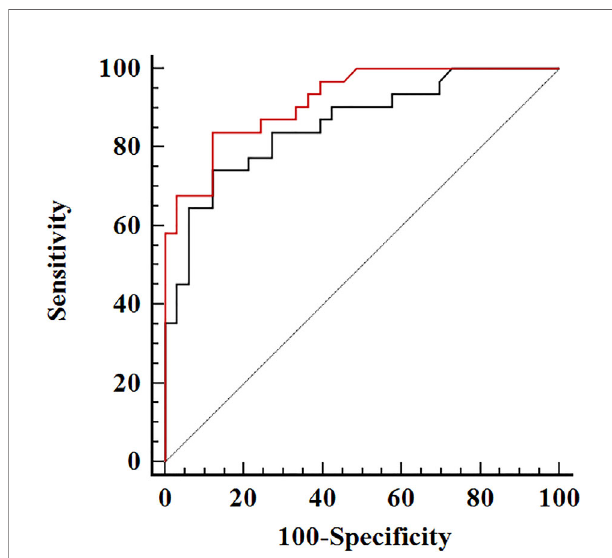
FIGURE 4 | Receiver operating characteristic curves of the combined contrast-enhanced ultrasound (CEUS) indicators in distinguishing primary thyroid lymphoma and nodular Hashimoto ’ s thyroiditis. The black curve represents the combination of three ratios for peak intensity, area under the time – intensity curve, and time to peak; the red curve represents the combination of the three ratios and the CEUS imaging features including the enhancement pattern and